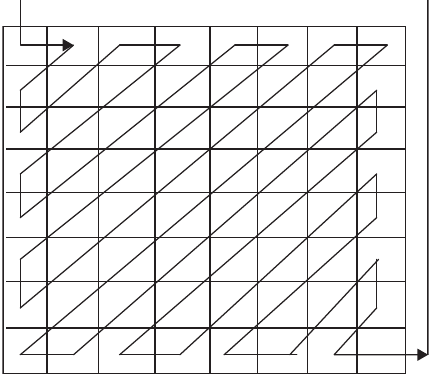
Figure 2: A zigzag path to scramble the binary